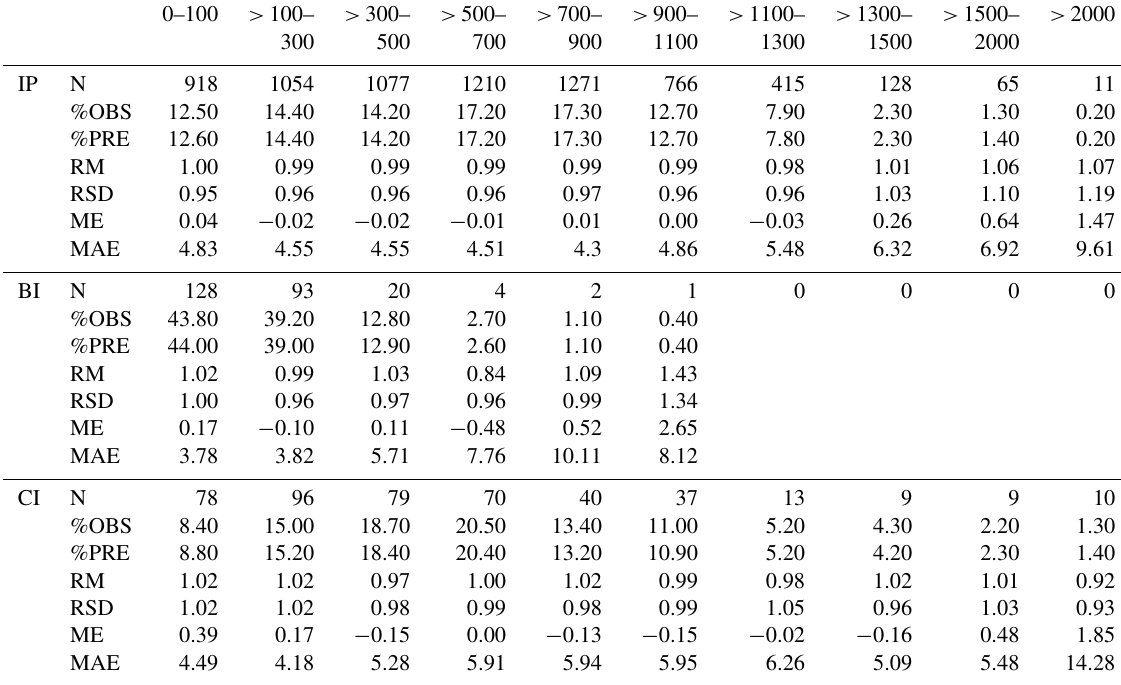
Table 4. The leave-one-out cross-validation (LOO-CV) statistics showing the goodness of fit between observations and estimations of daily precipitation separated by altitudes (ma.s.l.). IP: Iberian Peninsula; BI: Balearic Islands; CI: Canary Islands; N: number of stations; MAE: mean absolute error; ME: mean error; %OBS: percentage of observed precipitation; %PRE: percentage of predicted precipitation; RM: ratio of means; RSD: ratio of standard deviations. Results were constrained to 2 decimal